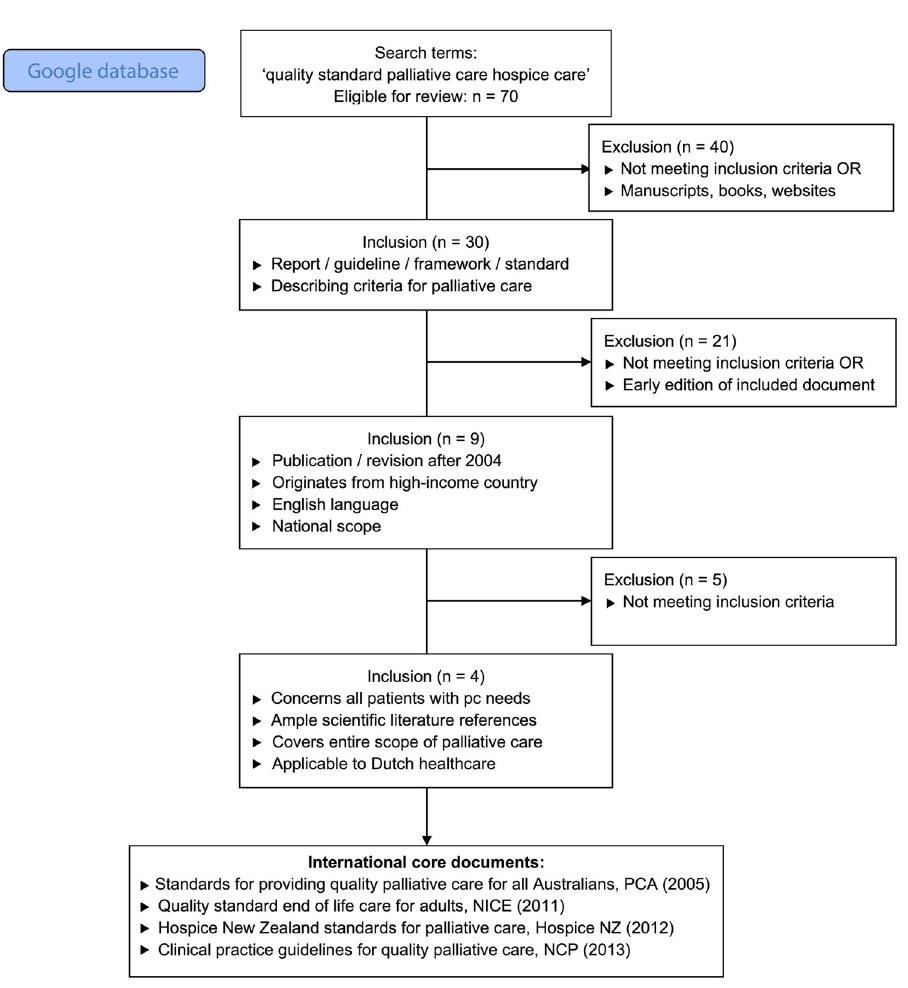
Fig 2. Flow diagram for the review of international